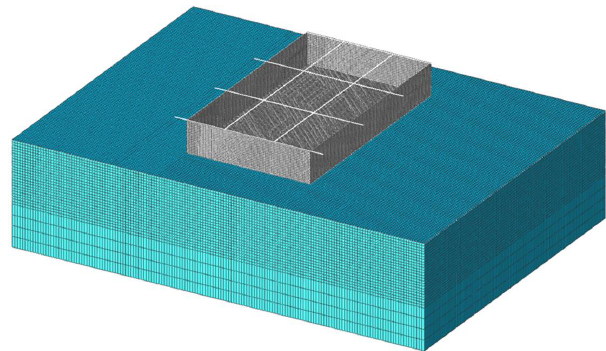
Figure 7. Finite element model for wet drop test.